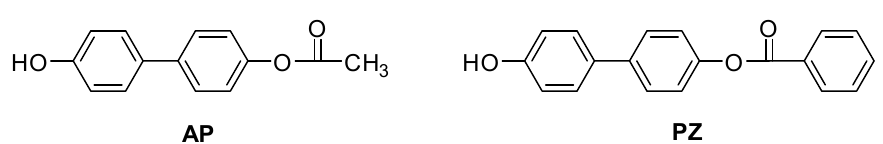
Figure 4. Structures of AP and PZ